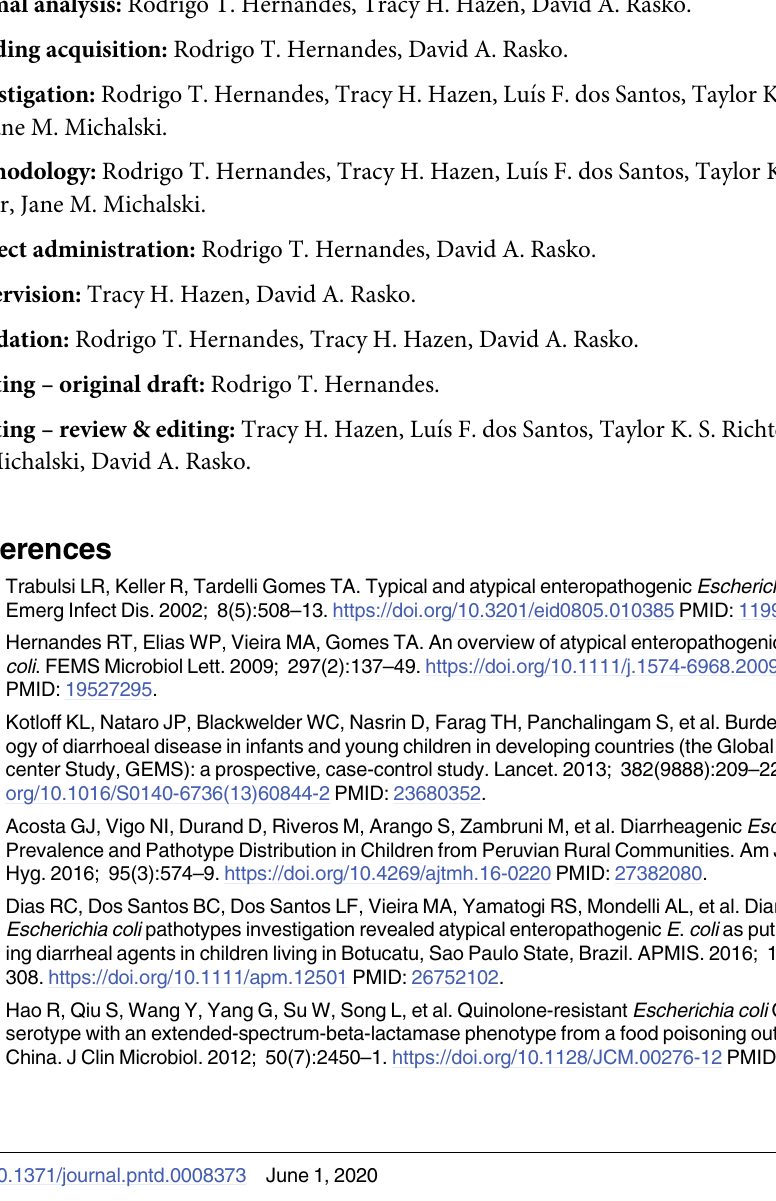
S6 Table. Gene clusters differentially detected among aEPEC from Brazil and from other origins by phylogenomic lineage. S7 Table. Occurrence of virulence factor-encoding genes in aEPEC obtained from diar- rheagenic patients and healthy subjects in